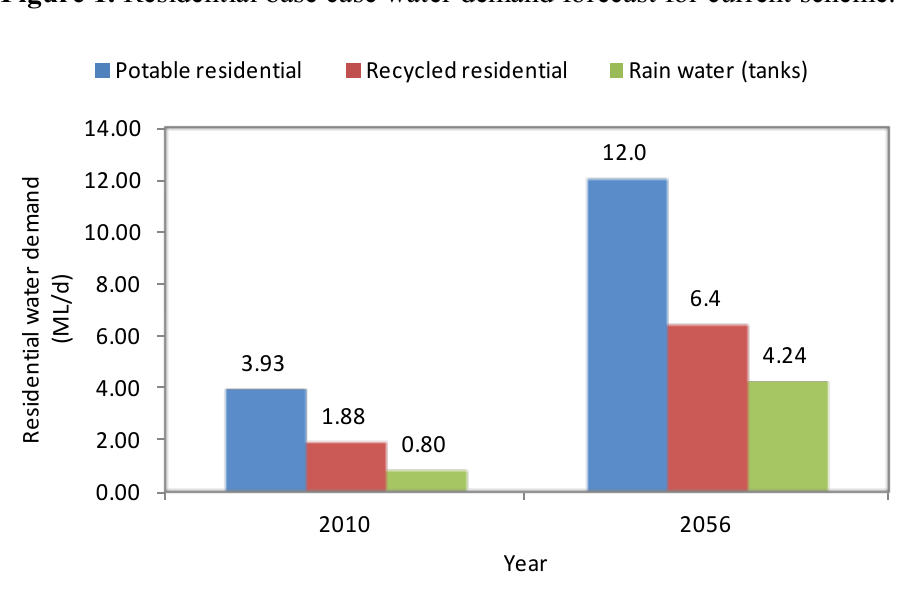
Figure 1. Residential base case water demand forecast for current scheme.